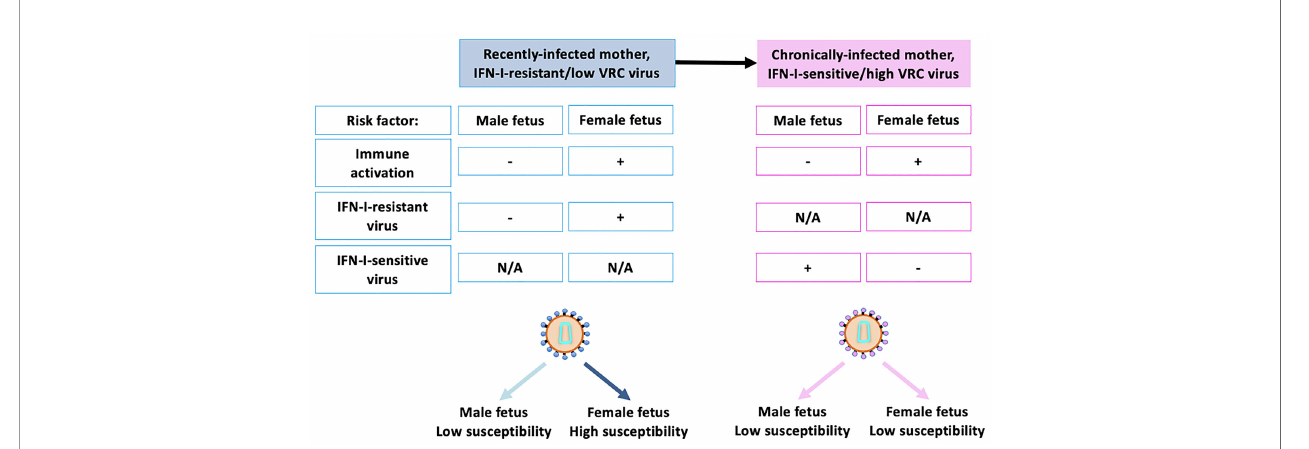
FIGURE 3 | Key risk factors contributing to sex differences in susceptibility to in utero infection. Recently-infected mothers typically carry highly IFN-I-resistant virus which tends have lower replicative capacity than IFN-I-sensitive virus. Female fetuses have higher levels of immune activation, even in the absence of exposure to HIV, and are also especially susceptible to infection to IFN-I-sensitive viruses. Male fetuses are not as susceptible to IFN-I-resistant viruses, for reasons incompletely understood, although this may be related to the fact that IFN-I-resistant viruses tend to have low replicative capacity. These factors together result in female fetuses being 2 – 3x more susceptible to in utero MTCT than male fetuses in the setting of recent maternal infection. Chronically infected mothers typically harbour IFN-I- sensitive viruses, to which male fetuses are somewhat more susceptible. Thus, taking into account the greater immune activation of female fetuses, male and female fetuses have similar susceptibility in the setting of chronic maternal infection. N/A, Not